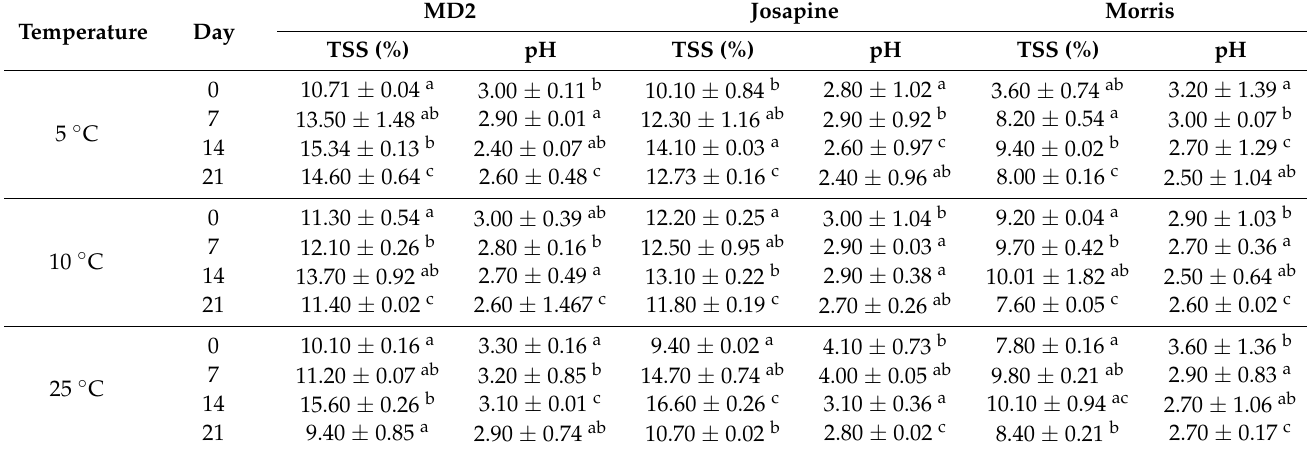
Table 1. Changes in total soluble solids and pH of pineapples at different storage temperatures during